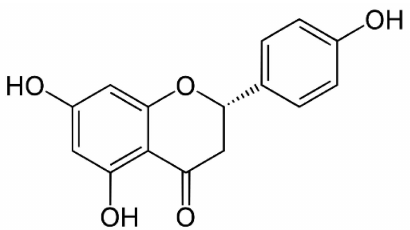
Figure 3. Structure of